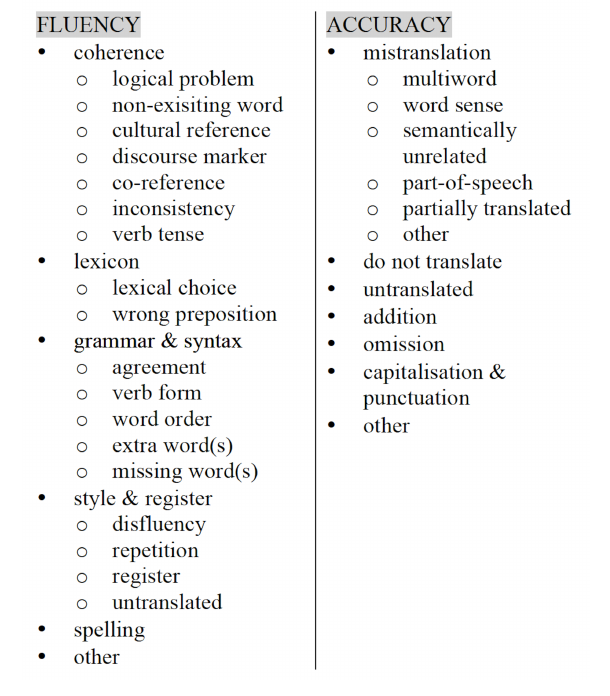
Figure 1. Overview of the SCATE error